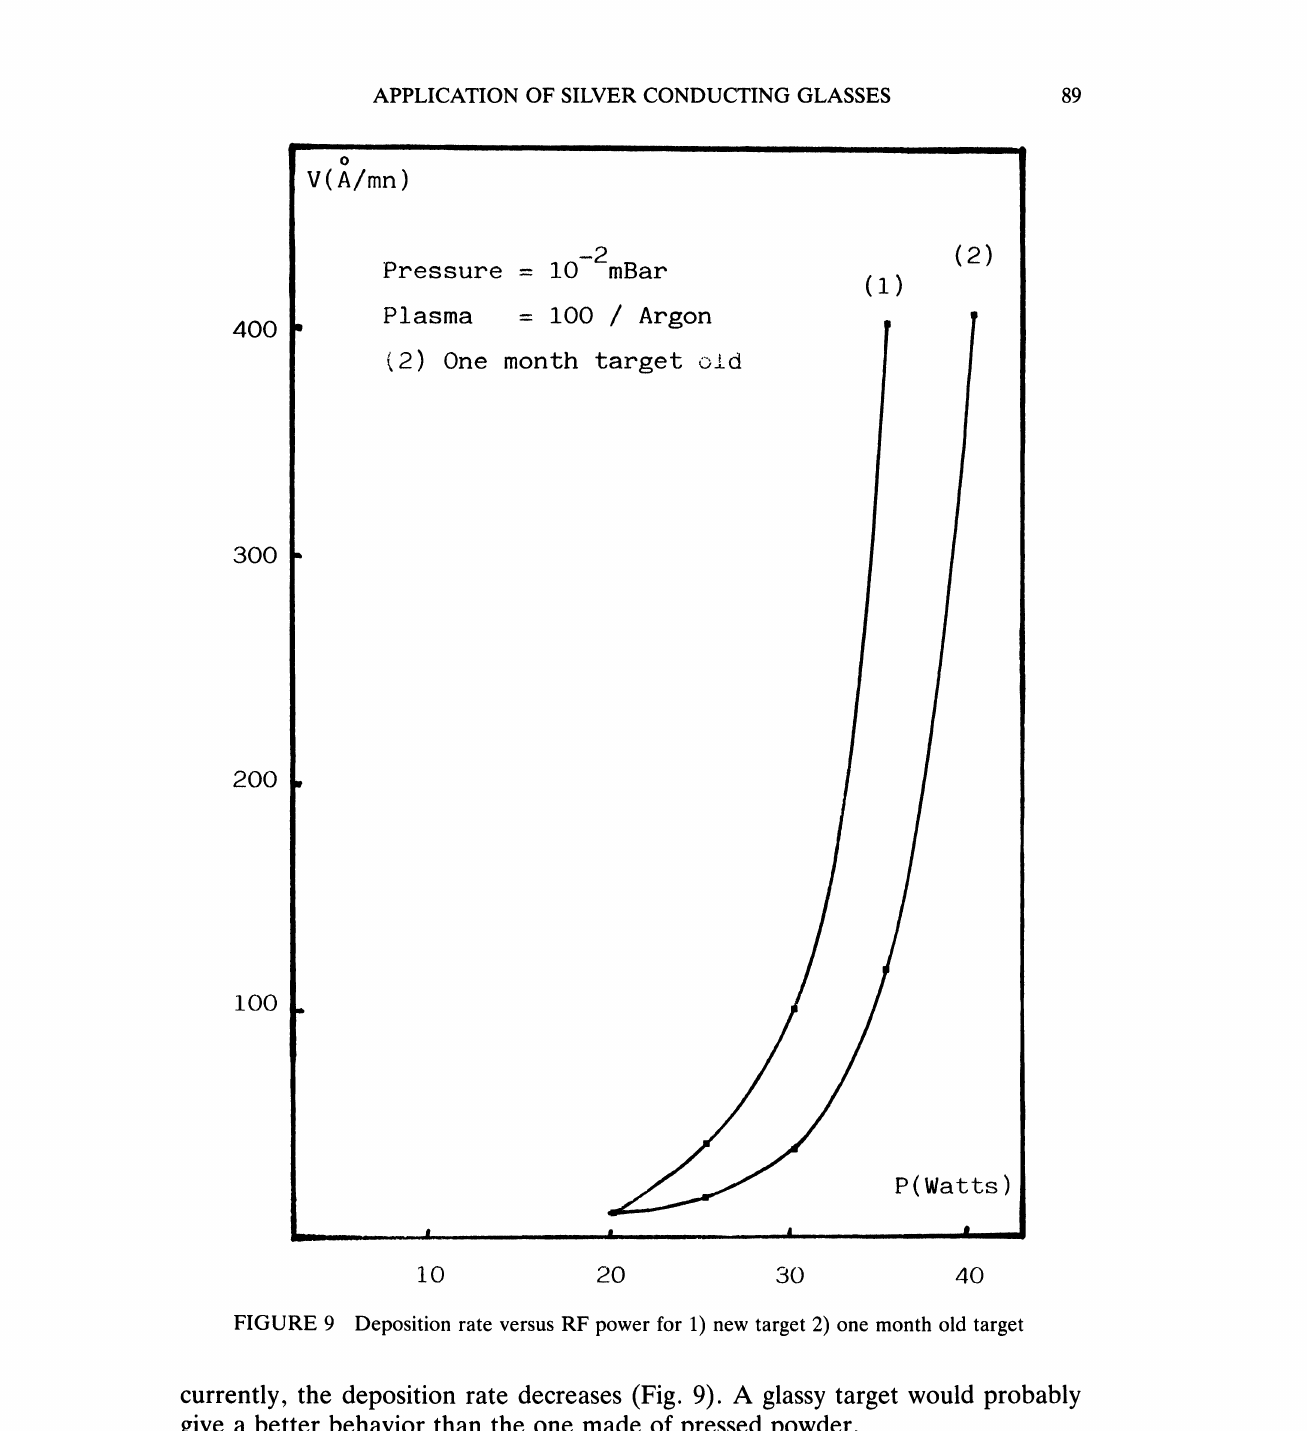
FIGURE 9 Deposition rate versus RF power for 1) new target 2) one month old